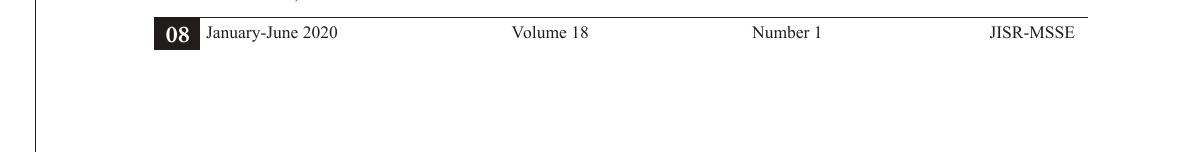
Figure 3: Zulfiqar Ali Bhutto wearing shalwar